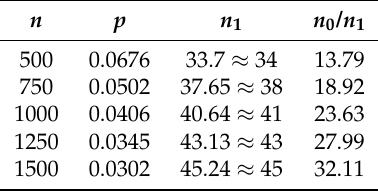
Figure 8. The objective function vs. p at α x ( 0 ) = 2, α x ( 1 ) = 4, α y ( 0 ) = 2, α y ( 1 ) = 3, r f = 100 m , and r c = 500 m . Table 3. The optimum value of p , n 1 , and n 0 / n 1 at α x ( 0 ) = 2, α x ( 1 ) = 4, α y ( 0 ) = 2, α y ( 1 ) = 3, r f = 100 m , and r c = 500 m